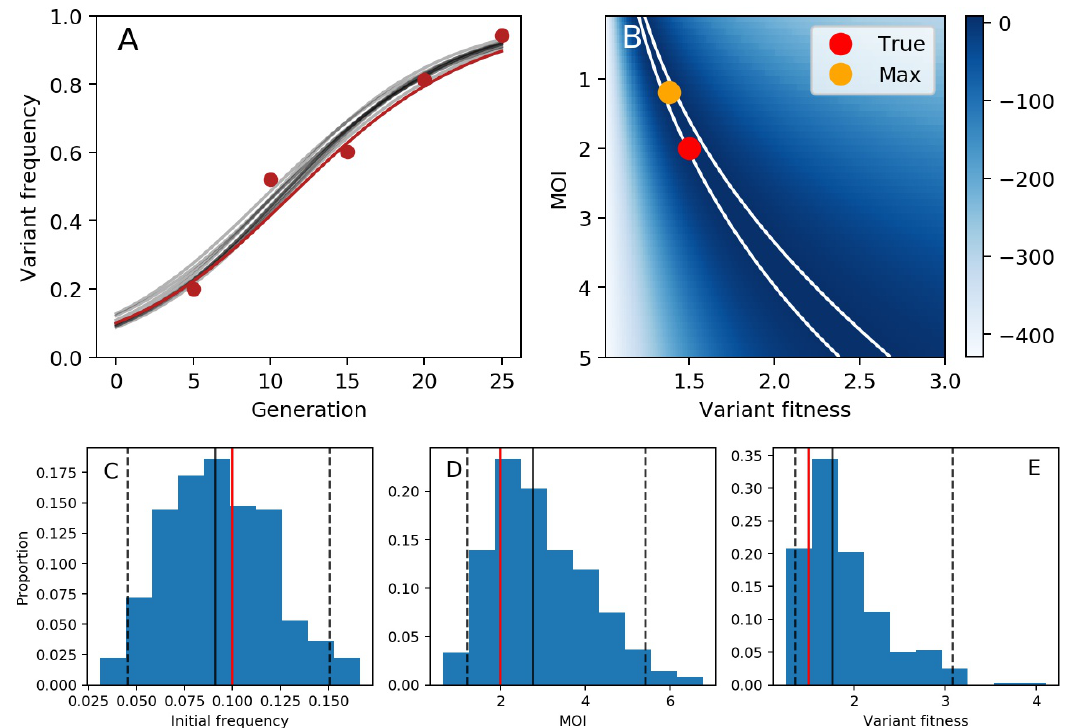
Figure 2. Variant fitness estimation under the assumption of deterministic evolutionary dynamics. ( A ) Mock data (red dots) generated from a forward simulation of the deterministic within-host evolution model with added measurement noise. The underlying deterministic dynamics are shown with a red line. The model is parameterized with variant fitness of e σ m = 1.5, a mean cellular MOI of M = 2.0, and an initial frequency of the variant of q m ( t 0 ) = 0.10. Measurement (observation) noise is set to ν = 100. Grey lines show 10 model simulations, with parameters drawn from the MCMC posterior distributions. ( B ) Log-likelihood landscape, showing the log-likelihood of the model over a broad range of MOI and variant fitness values. When calculating these likelihoods, the initial frequency of the variant and the measurement noise were fixed at their true values. The red dot shows the true set of parameters used to simulate the mock data. The yellow dot shows the parameter combination yielding the highest log-likelihood. White boundary lines show the 95% confidence interval of parameter estimates. ( C ) Posterior distribution for the initial frequency of the variant. ( D ) Posterior distribution for the mean cellular multiplicity of infection M . ( E ) Posterior distribution for variant fitness. In ( C – E ), black solid lines show the median values of the posterior density, black dashed lines show the 95% credible intervals, and red solid lines show the true